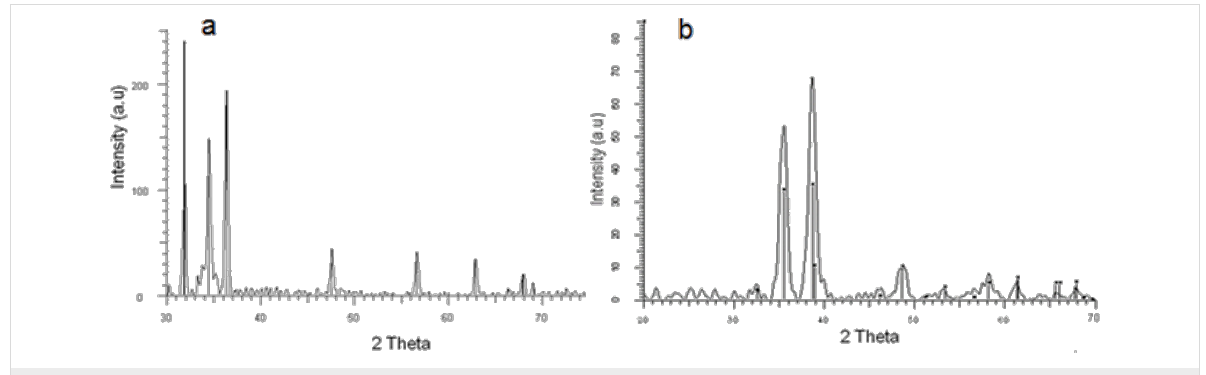
Figure 1: XRD patterns of sonochemically coated fabrics with: (a) ZnO and (b) CuO NPs.